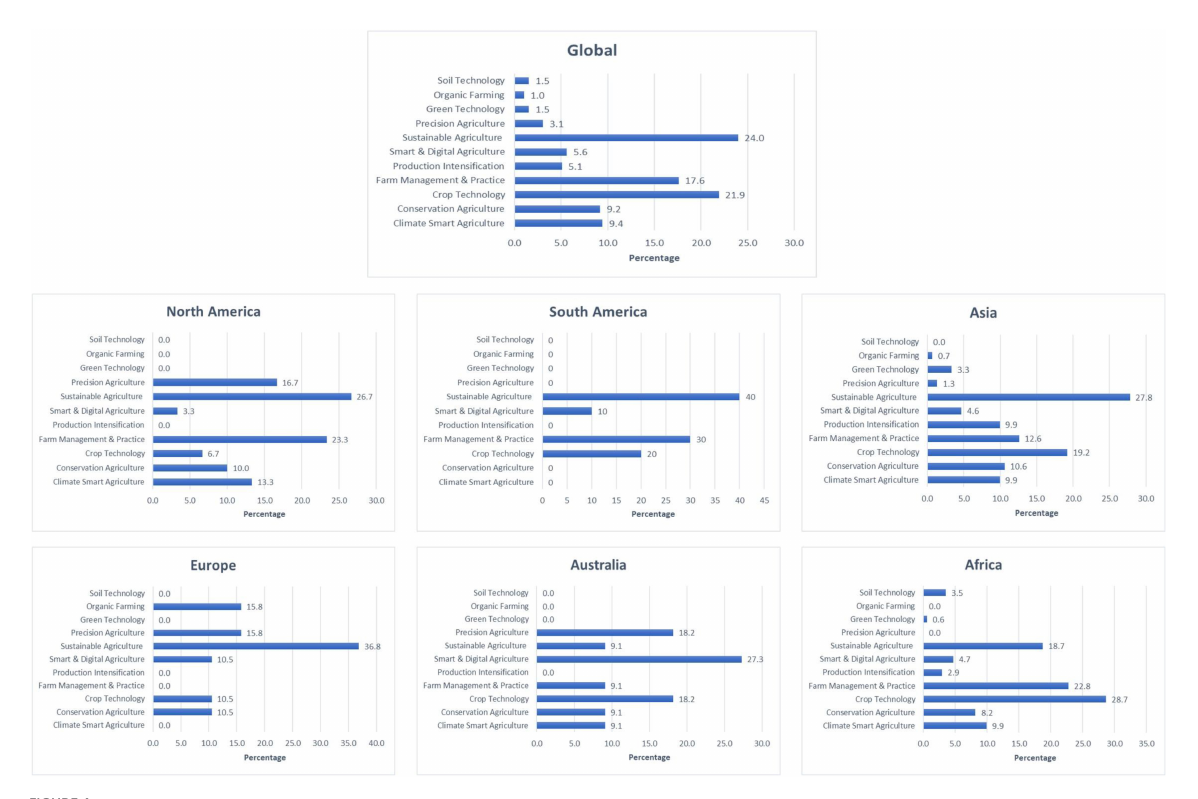
FIGURE4 Types of innovation and new technologies according to